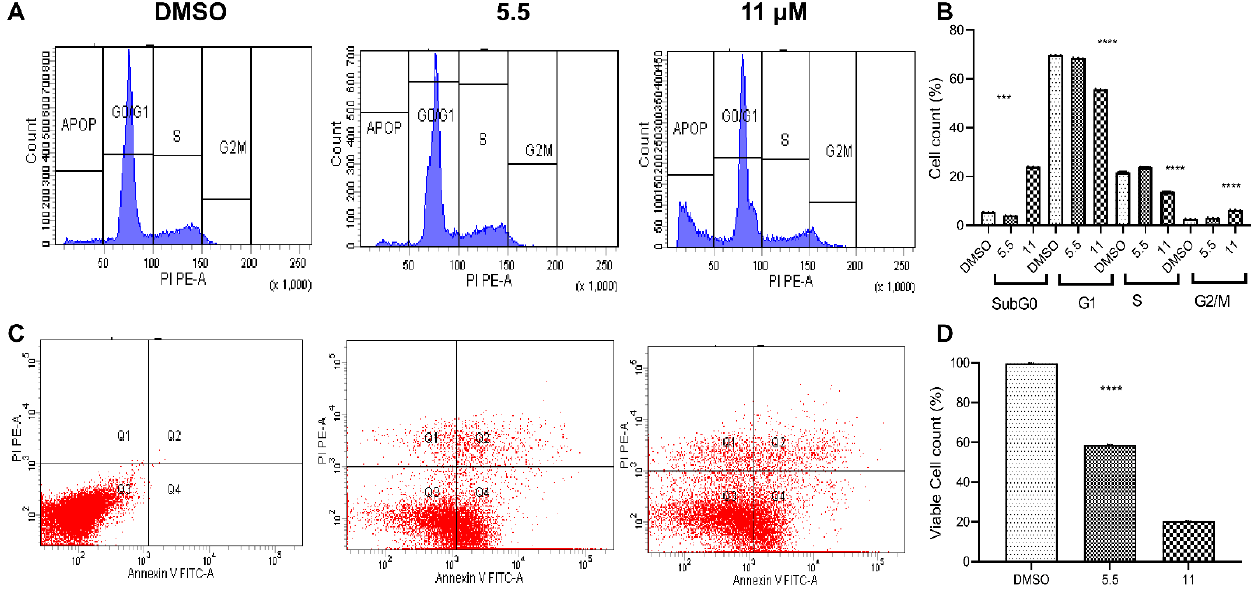
Figure 8. Flow cytometric studies of 12b in HepG-2 cells: ( A ) Cell-cycle distribution. ( B ) histogram for the change in cell count in each phase in comparison to the control cells. Cells were treated with increasing concentrations for 48 h: control (DMSO), 5.5 µM (1/2 IC 50 ), and 11 µM (IC 50 ). ( C ) Apoptotic effect of 12b through Annexin-V-FITC/PI staining assay. Cells were treated with 12b at the tested concentrations for 24 h. ( D ) Histograms for induction of apoptosis and showing the decrease in viable cell count. **** = significant results in comparison to DMSO-treated cells ( p < 0.0001). the statistical difference was analyzed by One-Way ANOVA by GraphPad Prism 8.0.